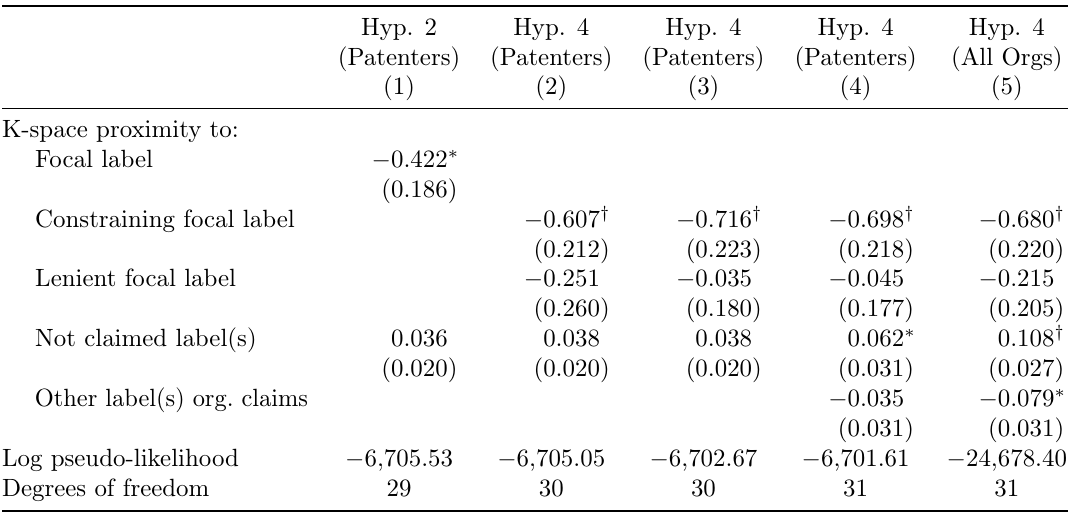
Table 4: Effects of Proximity and Leniency on the Hazards of Dropping a Label (ML Estimates of Piecewise-Continuous Hazard